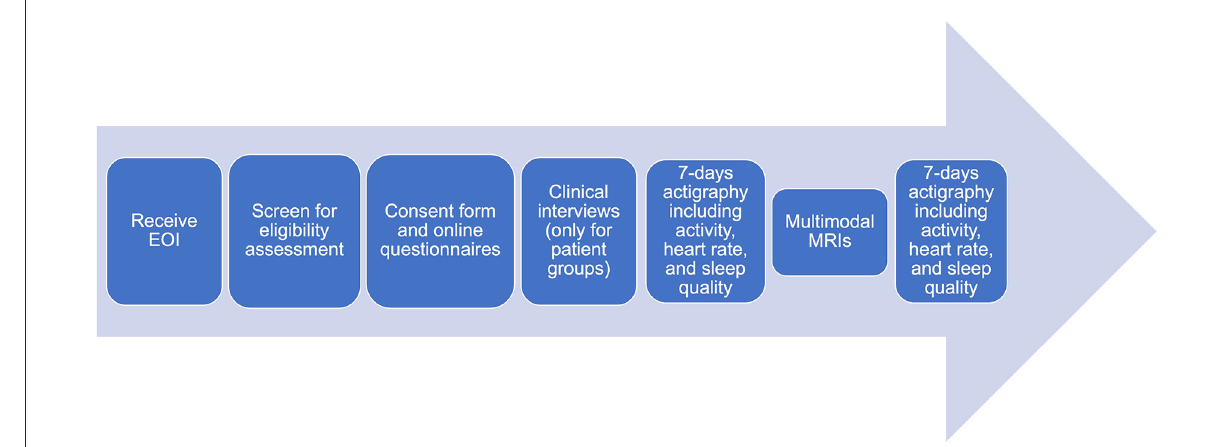
FIGURE1 Flowchart for data